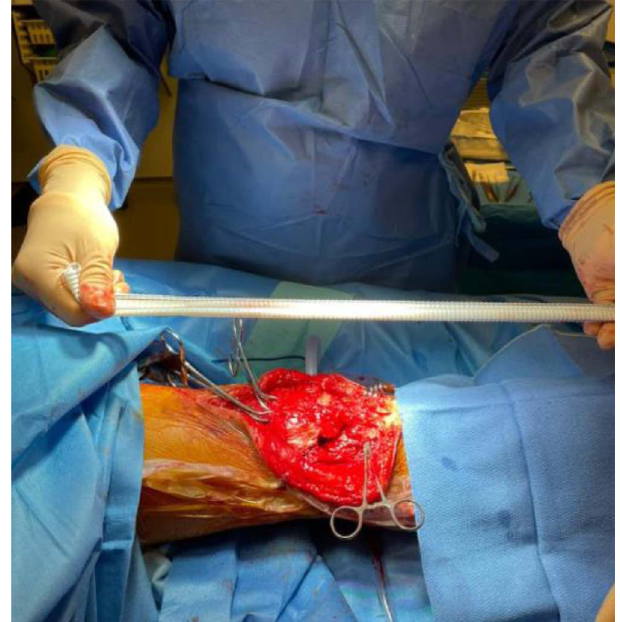
Figure 7. Tensioning of the vascular